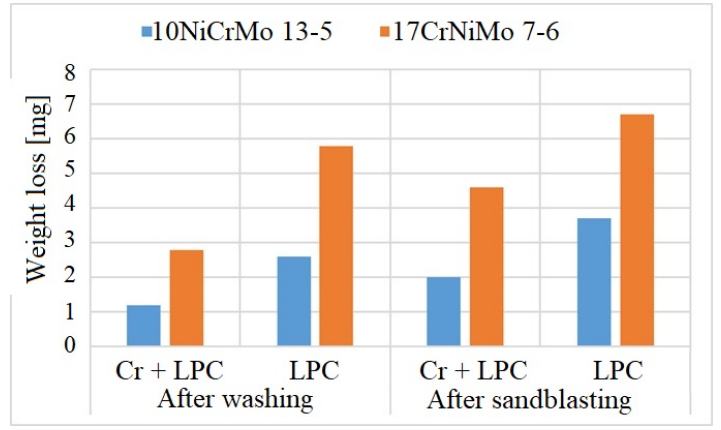
Figure 6. Weight loss for 10NiCrMo 13-5 and 17CrNiMo 7-6 steels after test of resistance to humidity-samples after washing and sandblasting.